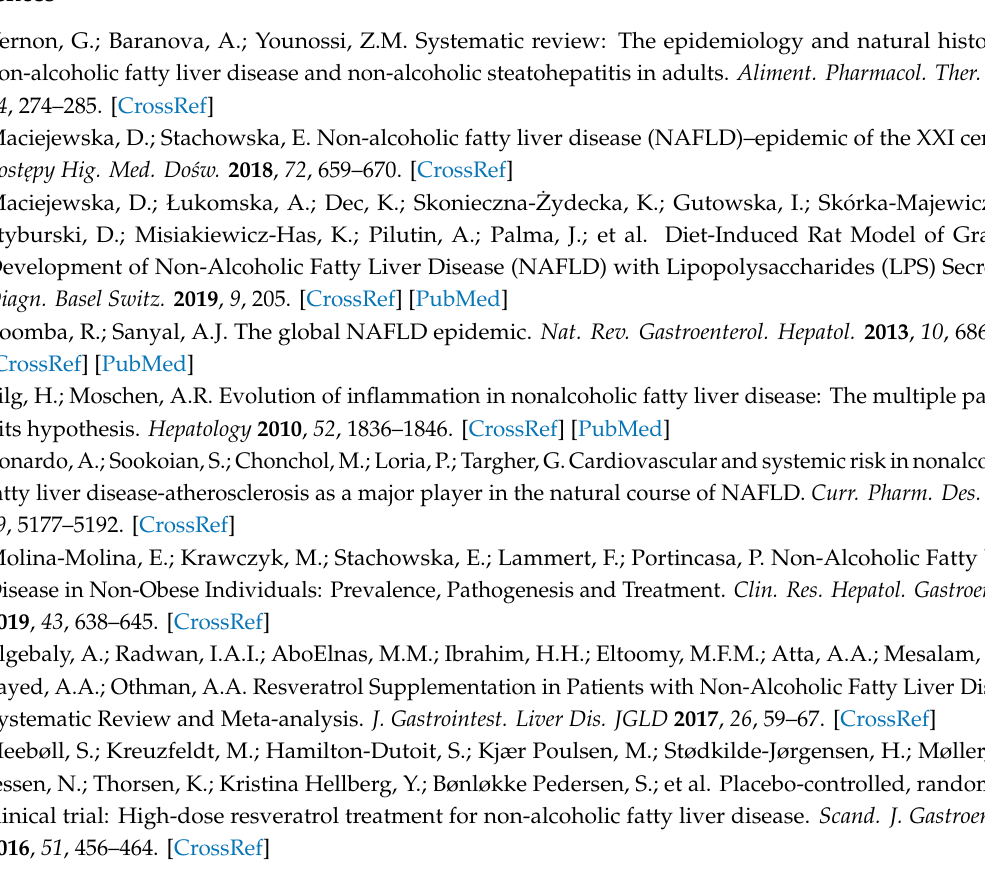
I-squared = 16.396; Figure S10. E ff ect size, standardized mean di ff erence, for HDL in persons taking RSV vs. controls (endpoint data). Q = 0.532, df(Q) = 1, p = 0.466, I-squared = 0.0; Figure S11. E ff ect size, standardized mean di ff erence, for SBP in persons taking RSV vs. controls (endpoint data). Q = 4.638, df(Q) = 3, p = 0.200, I-squared = 35.317; Figure S12. E ff ect size, standardized mean di ff erence, for DBP in persons taking RSV vs. controls (endpoint data). Q = 0.007, df(Q) = 2, p = 0.996, I-squared = 0.0; Figure S13. Funnel plot for the e ff ect of resveratrol on the level of ALT in patients with NAFLD in present meta-analysis; Figure S14. Funnel plot for the e ff ect of resveratrol on the level of AST in patients with NAFLD in present meta-analysis; Figure S15. Funnel plot for the e ff ect of resveratrol on the body weight in patients with NAFLD in present meta-analysis; Figure S16. Funnel plot for the e ff ect of resveratrol on the BMI in patients with NAFLD in present meta-analysis; Figure S17. Funnel plot for the e ff ect of resveratrol on the WC in patients with NAFLD in present meta-analysis; Figure S18. Funnel plot for the e ff ect of resveratrol on the level of glucose in patients with NAFLD in present meta-analysis; Figure S19. Funnel plot for the e ff ect of resveratrol on the level of TC in patients with NAFLD in present meta-analysis; Figure S20. Funnel plot for the e ff ect of resveratrol on the level of LDL in patients with NAFLD in present meta-analysis; Figure S21. Funnel plot for the e ff ect of resveratrol on the level of SBP in patients with NAFLD in present meta-analysis; Figure S22. Funnel plot for the e ff ect of resveratrol on the level of DBP in patients with NAFLD in present meta-analysis. Table S1. Additional parameters related to NAFLD that were not included in the meta-analysis, Table S2. Baseline parameters related to